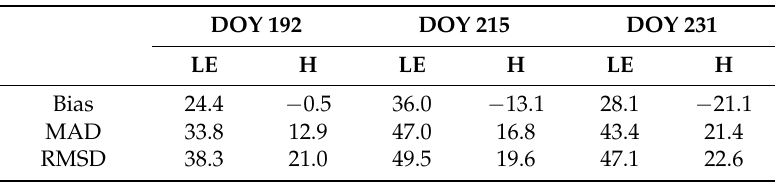
Table 6. Statistics for comparing OSML- and SEBS-derived H and LE for the kernel experimental area in MUSOEXE (W/m 2 ).